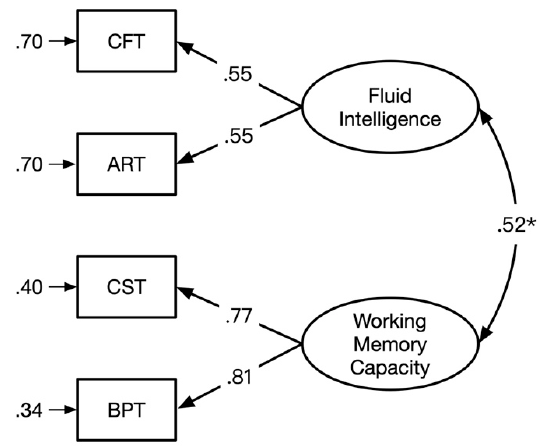
Figure 2. The two-factor model including fluid intelligence and working memory capacity as two distinct but correlated constructs. The culture fair test (CFT) and abstract reasoning test (ART) were loaded on fluid intelligence, and the complex span task (CST) and Brown–Peterson task (BPT) were loaded on working memory capacity (* p < .05). Table 2. Fit statistics of the measurement models for working memory capacity, fluid intelligence, and executive processes based on the star counting task. WMC, working memory capacity; Gf, fluid intelligence; EF, executive function; AIC, Akaike’s information criterion. Measur es